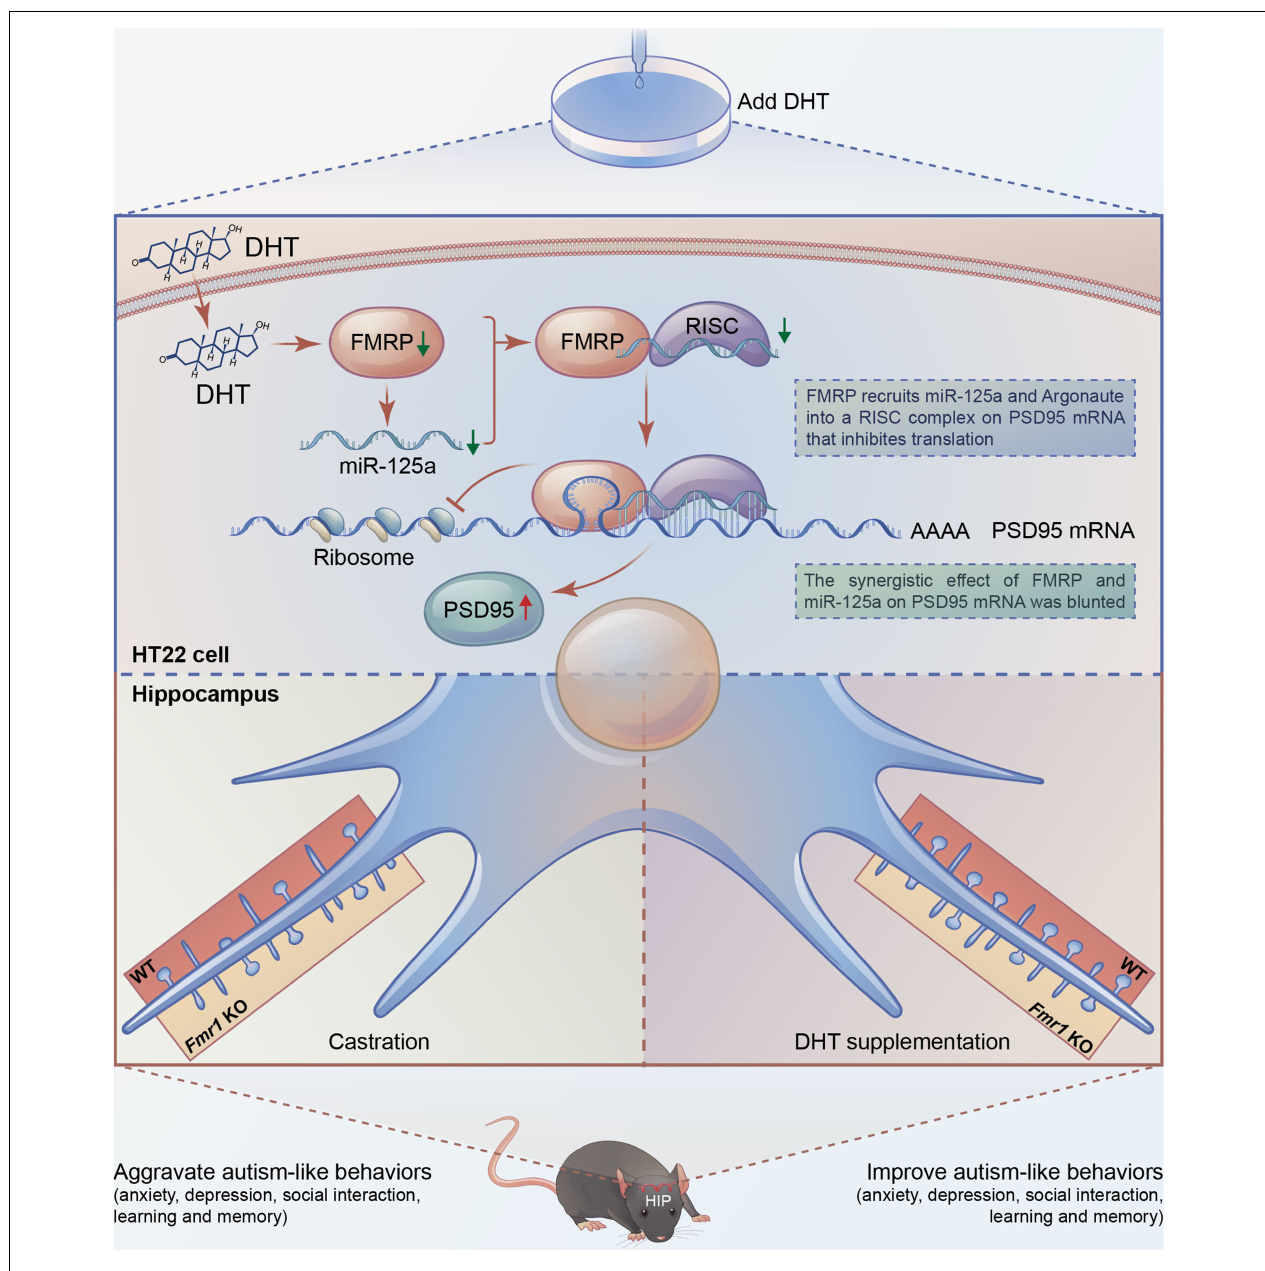
FIGURE 8 | Integration of FMRP and miR-125a associatively regulating the effects of DHT on synaptic plasticity and autism-like